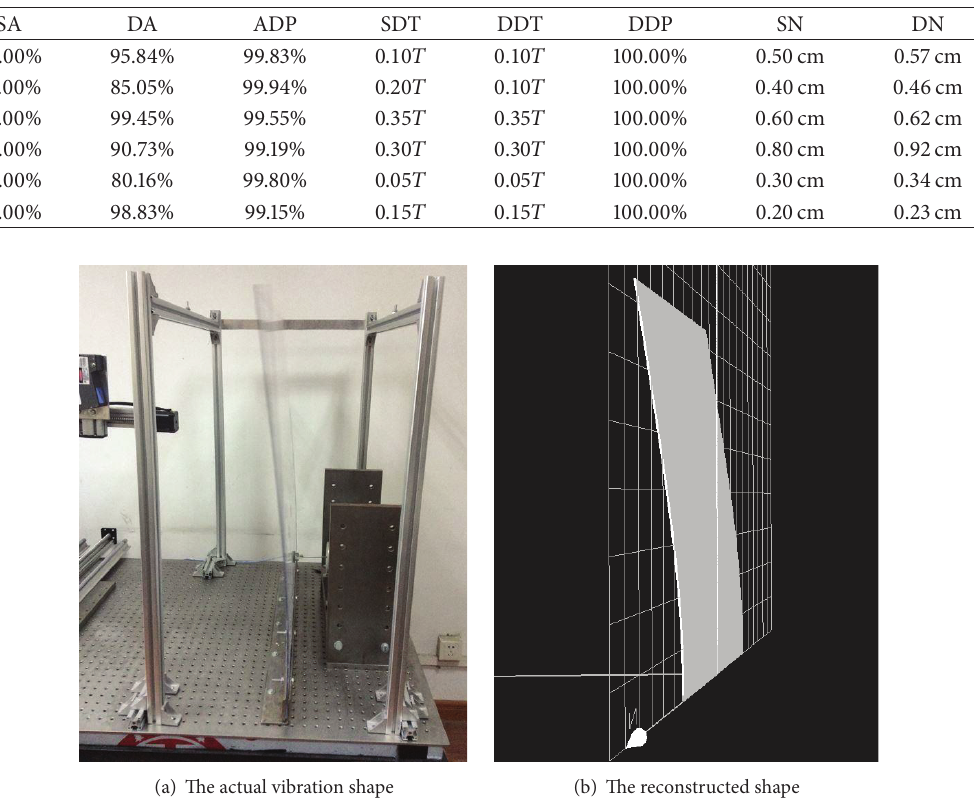
Figure 14: Shape reconstruction for the second